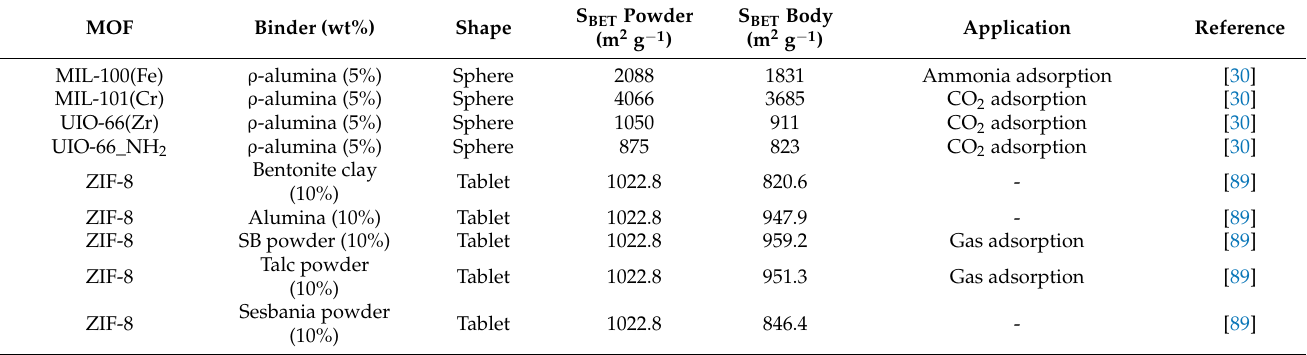
Table 2. Summary of shaped MOFs with inorganic